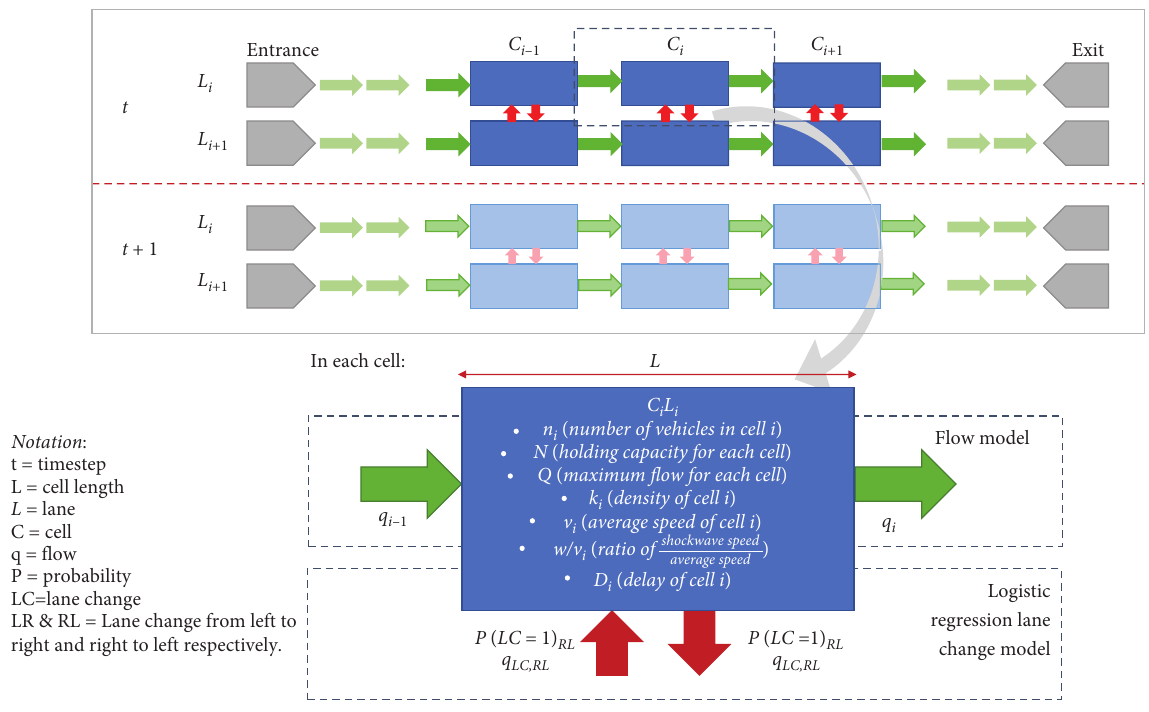
Figure 1: Cell representation of CTM.